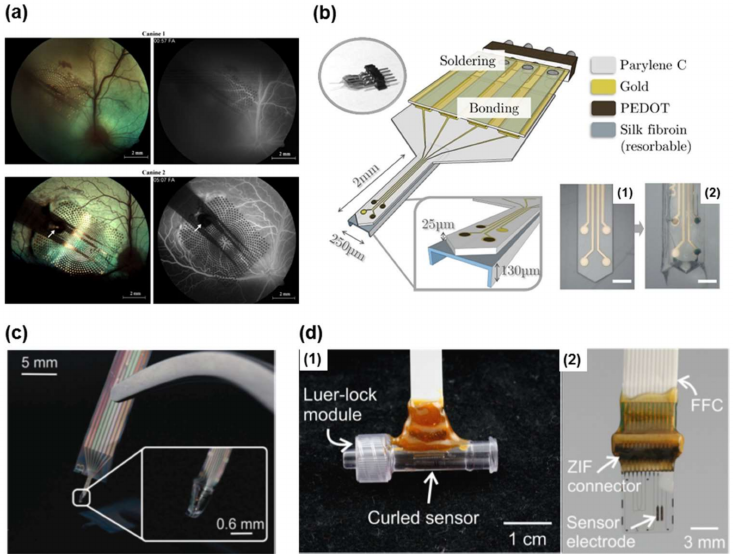
Figure 4. ( a ) Fundus photographs ( left ) showing parylene multi-electrode arrays (MEAs)